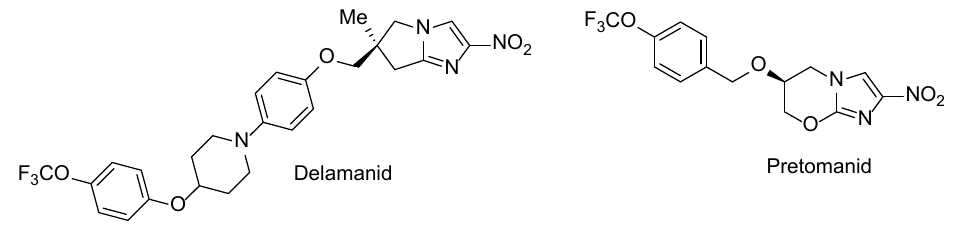
Figure 1. Clinically approved drugs delamanid and pretomanid.